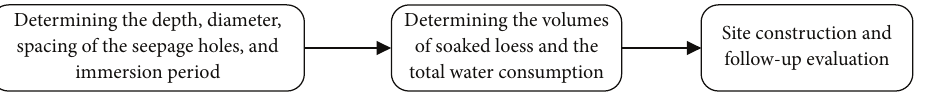
Figure 1: Steps of the borehole preimmersion